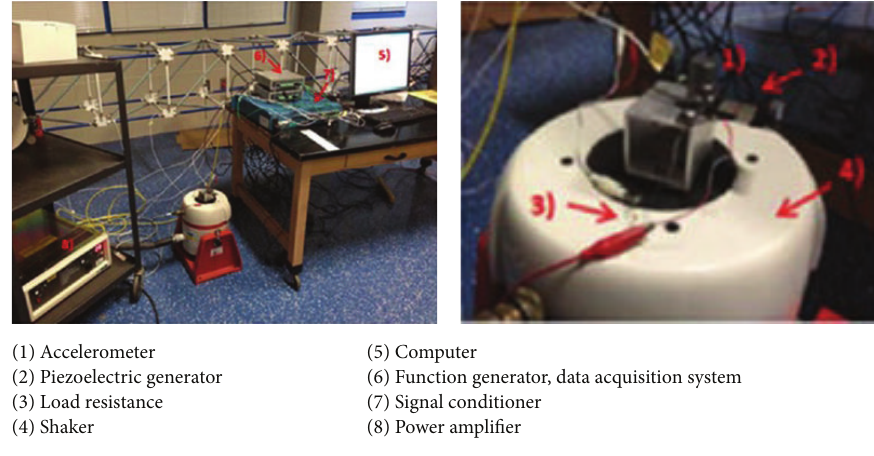
Figure 19: Experiment setup for model validation